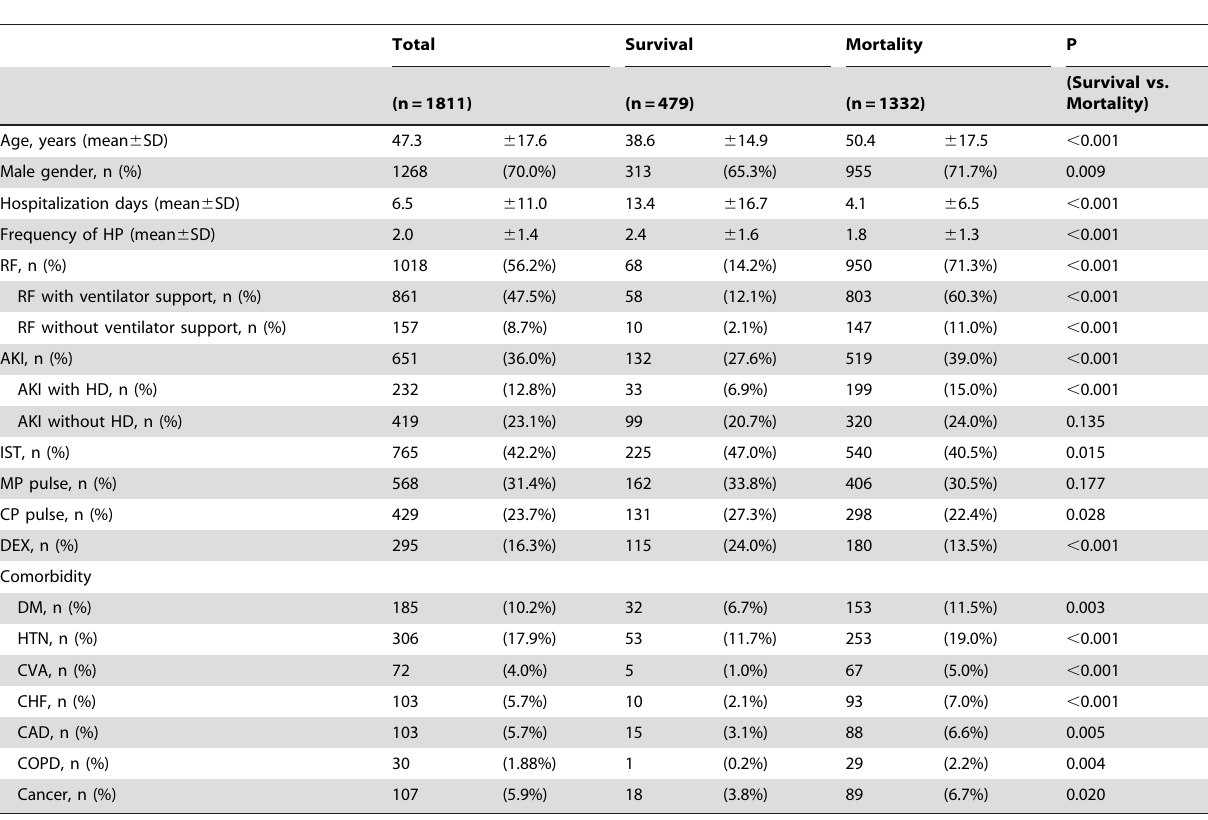
Table 1. Characteristics of study subjects classified by survival